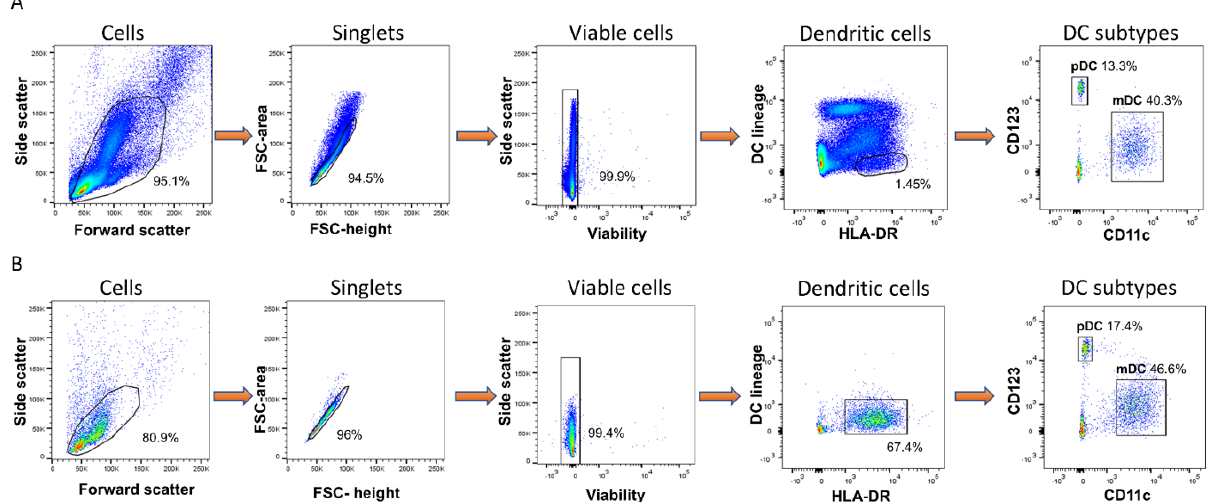
Figure 1. Enrichment of human blood myeloid and plasmacytoid dendritic cells from fresh PBMC. DCs were identified using side/forward scatter properties, doublet discrimination and gating on viable cells. Cells that were HLA-DR + and lineage – (CD3, CD14, CD16, CD19 and CD34) were further divided into mDCs (CD11c + CD123 - ) and pDCs (CD11c - CD123 + ). ( A ) DC identification within PBMC population before DC enrichment. ( B ) DC identification after